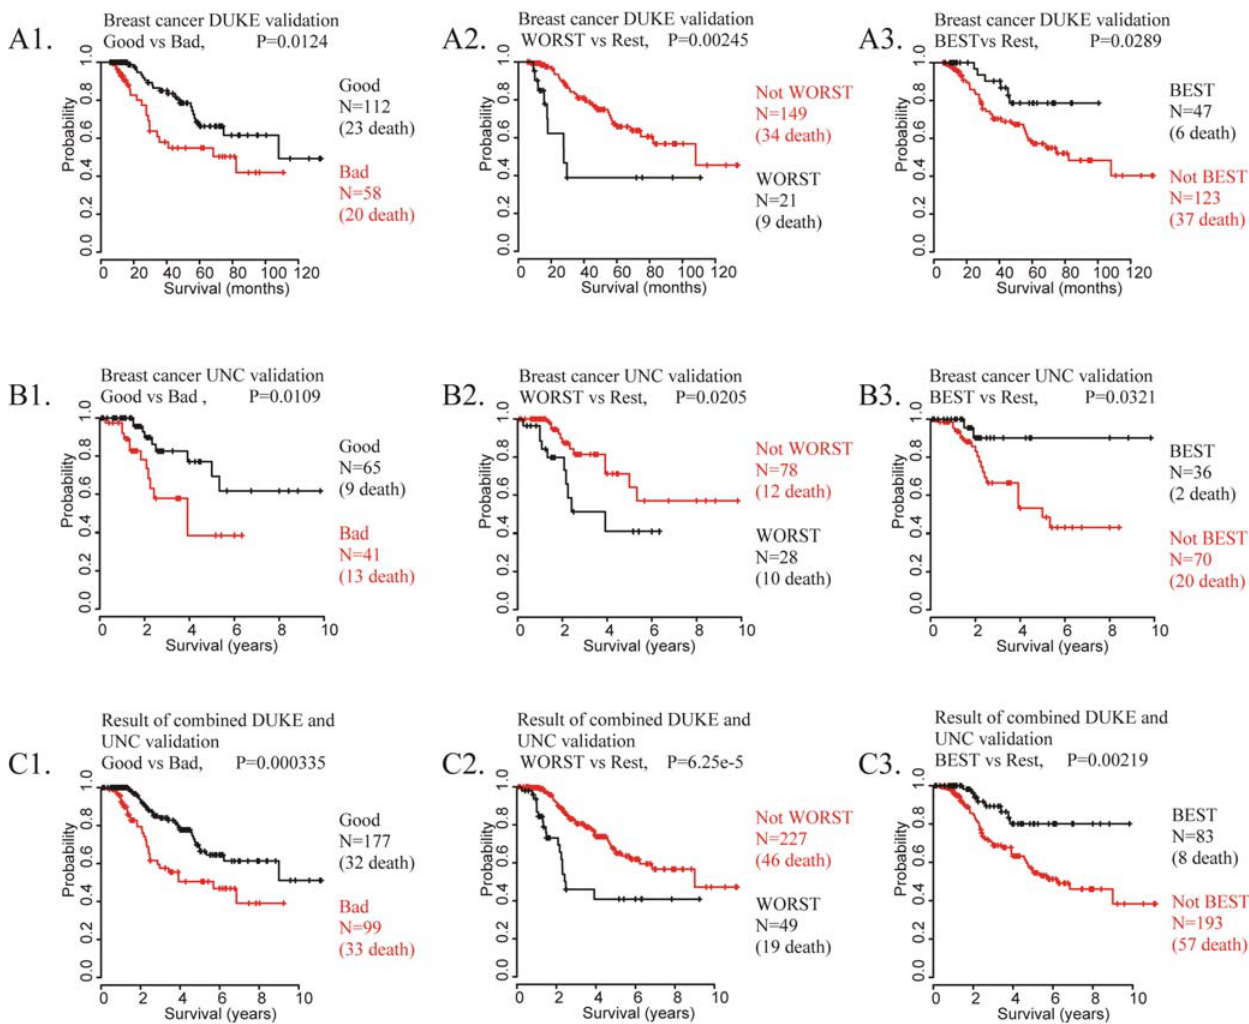
Figure 7. Prediction of independent cohorts of human breast cancer patients The results are shown as the summarized predicted outcomes determined from the results of 6 different prediction algorithms. A. Kaplan-Meier plots for the summarized predicted outcomes of Duke University patients [4]. B. Kaplan-Meier plots for the summarized predicted outcomes of UNC patients [5]. C. Kaplan-Meier plots for the combined predicted outcomes of UNC data and Duke University